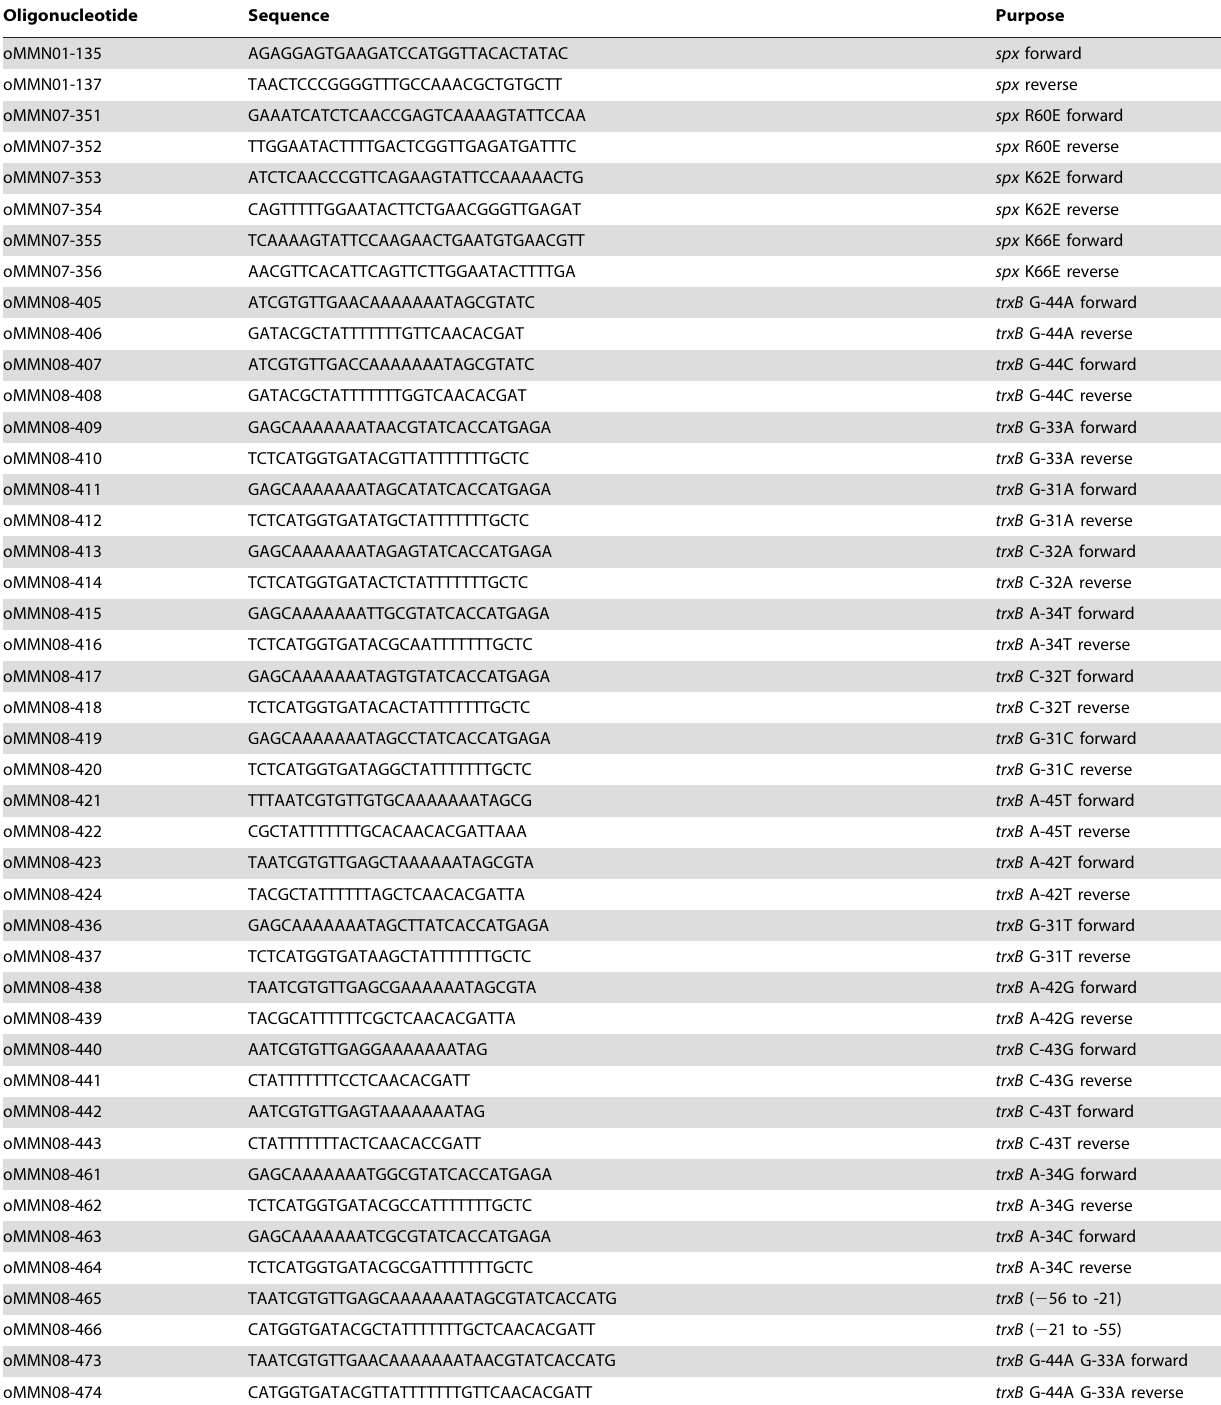
Oligonucleotide